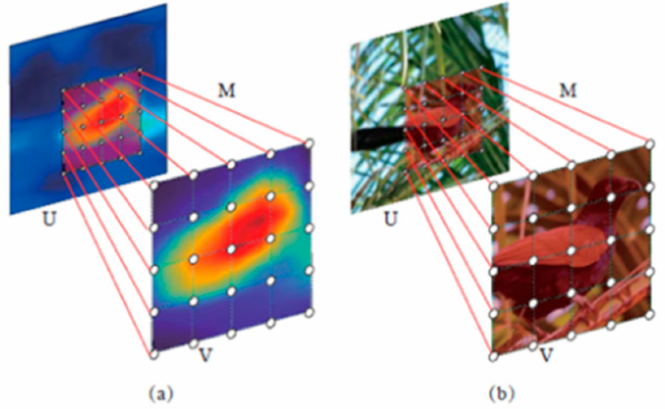
Figure 3. Illustration of coordinate grid mapping. ( a ) The coordinate grid mapping between feature maps ( b ) The coordinate grid mapping between input